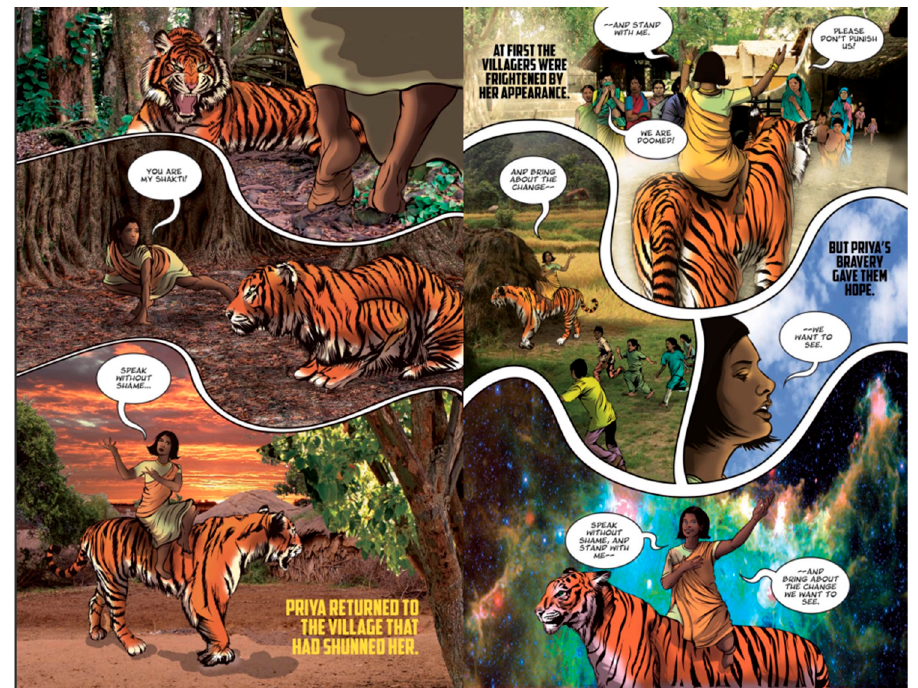
Figure 7. An empowered Priya returns to her village riding a tiger. Image Courtesy: Ram Devineni.